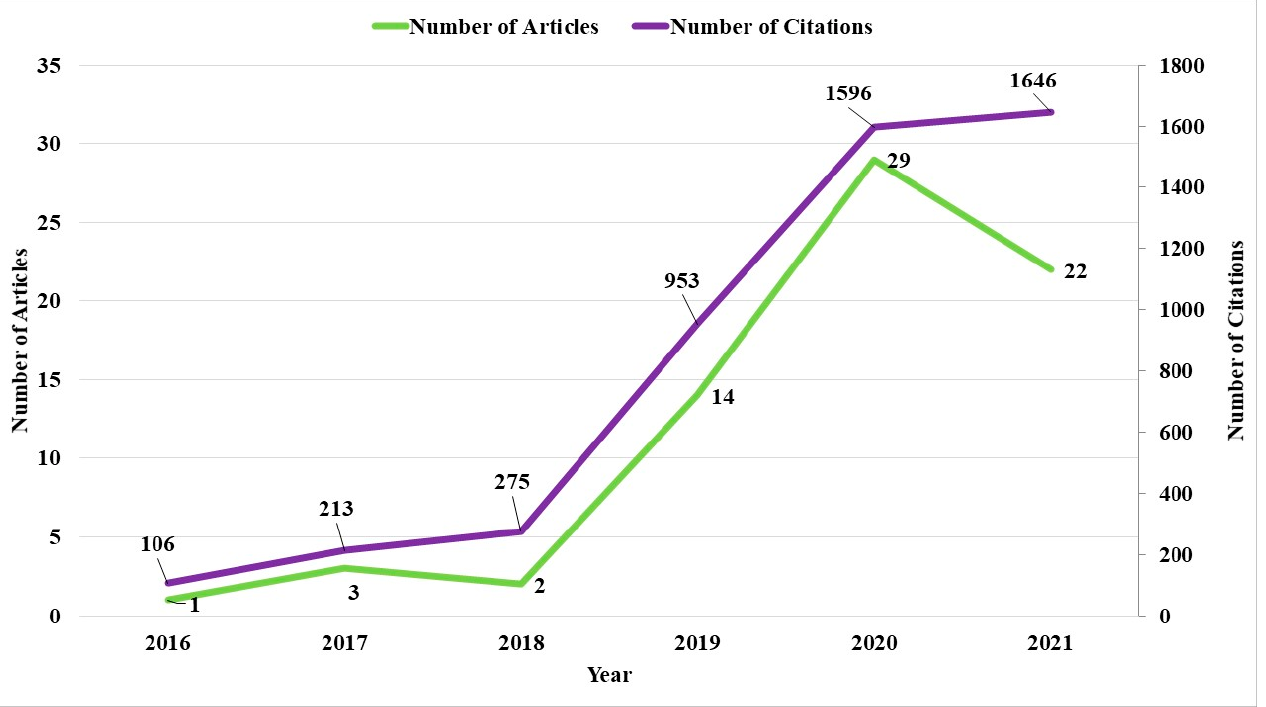
Figure 3. Number of publications/citations studied per year.